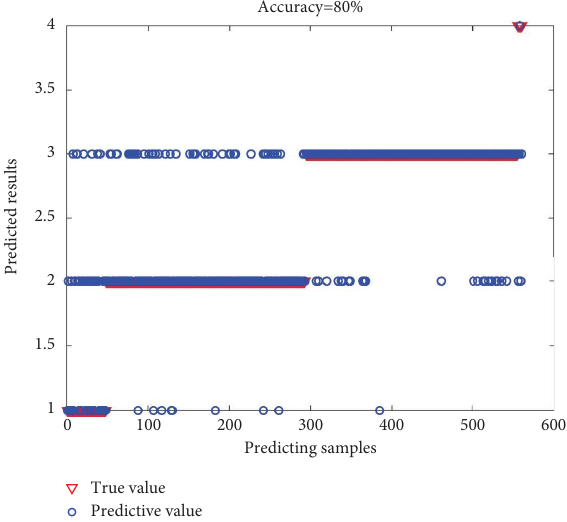
Figure 6: Comparison of test set prediction